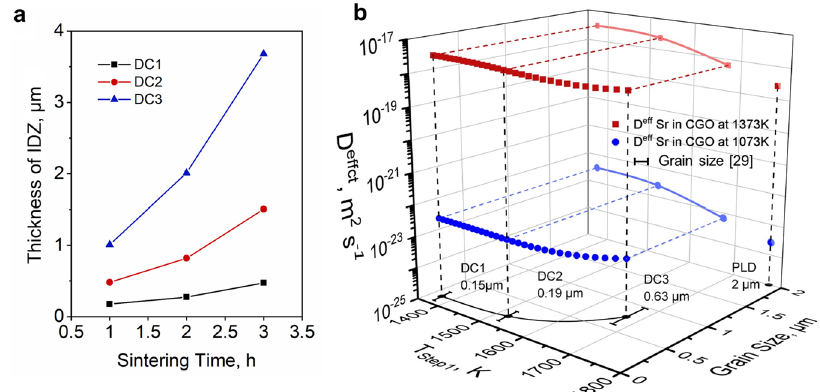
Fig. 7 Numerical analysis on changes of the microstructural parameters during the oxygen electrode – electrolyte interface reactions. a Simulated IDZ thickness for DC1, DC2, and DC3 after the barrier sintering step at 1100, 1250, and 1400 °C. b The estimated effective interdiffusion coef fi cient of Sr in CeO 2 barrier layer at 1073 K and 1373 K plotted against the sintering temperature of Step 1 and the corresponding grain size of CGO. The solid lines show the general trend and the dashed lines are to aid fi gure analysis. The error bars show the range of measured grain size reported in literature 29